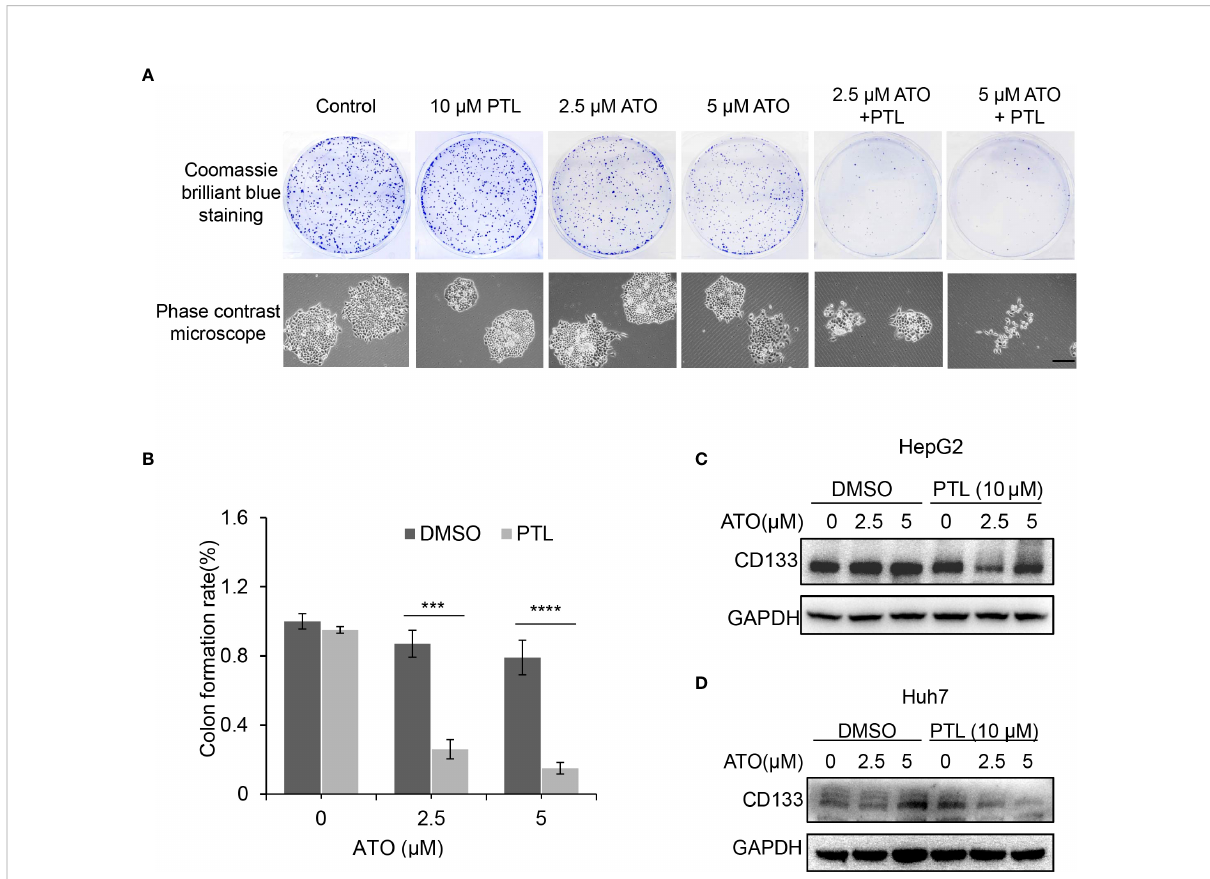
FIGURE 4 Suppression of stemness and self-renewal ability of HepG2 cells by combination of ATO with PTL. (A) HepG2 cells were treated with ATO, PTL and ATO plus PTL. After 12 days, cell clones were stained with coomassie brilliant blue. The number of colones was counted and the morphology of single clone was observed under the microscope (>50 clones validated). (B) Graphic quantitation of clone was obtained from at least three independent experiments. Columns, mean; bars, ± S.D. (*** P < 0.001; **** P < 0.0001). (C, D) HepG2 cells and Huh7 cells were treated as (A) , and then subjected to western blotting